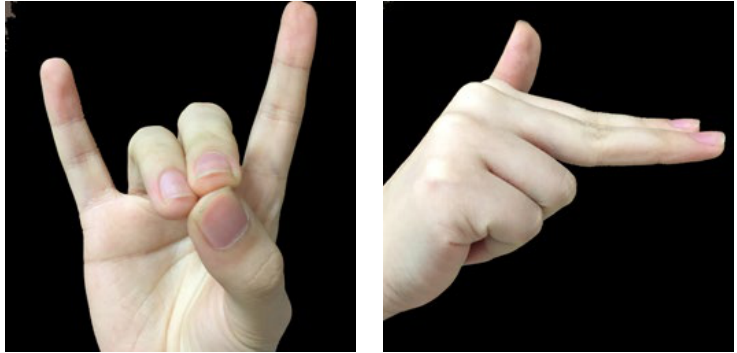
Figure 3. Remove and downsample (256 × 256) hand parts from the background. The first group of images, (left) T; (right) SH.